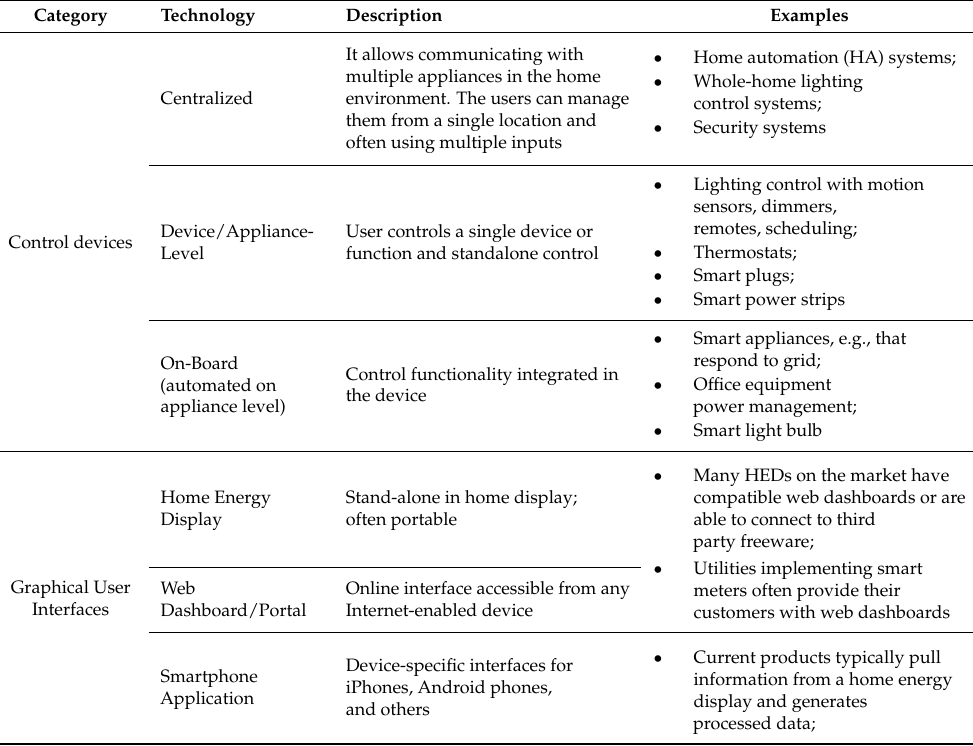
Table 3. Descriptions and examples of HEMSs. Source: